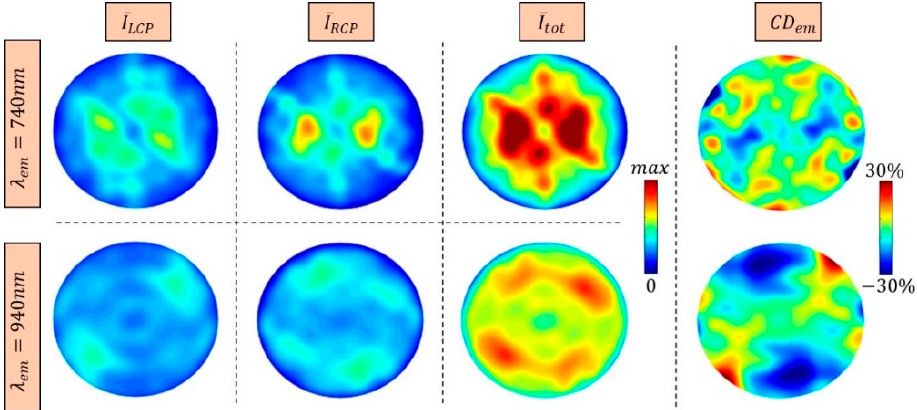
Figure 6. I̅ (cid:2896)(cid:2887)(cid:2900) , I̅ (cid:2902)(cid:2887)(cid:2900) , I̅ (cid:2930)(cid:2925)(cid:2930) , and CD em maps for the ensemble of 85 homogeneously distributed ran- Figure 6. I LCP , I RCP , I tot , and CD em maps for the ensemble of 85 homogeneously distributed randomly domly oriented dipoles for the Au-ENHA, at 740 nm ( top ), and 940 nm ( bottom ). oriented dipoles for the Au-ENHA, at 740 nm ( top ), and 940 nm ( bottom